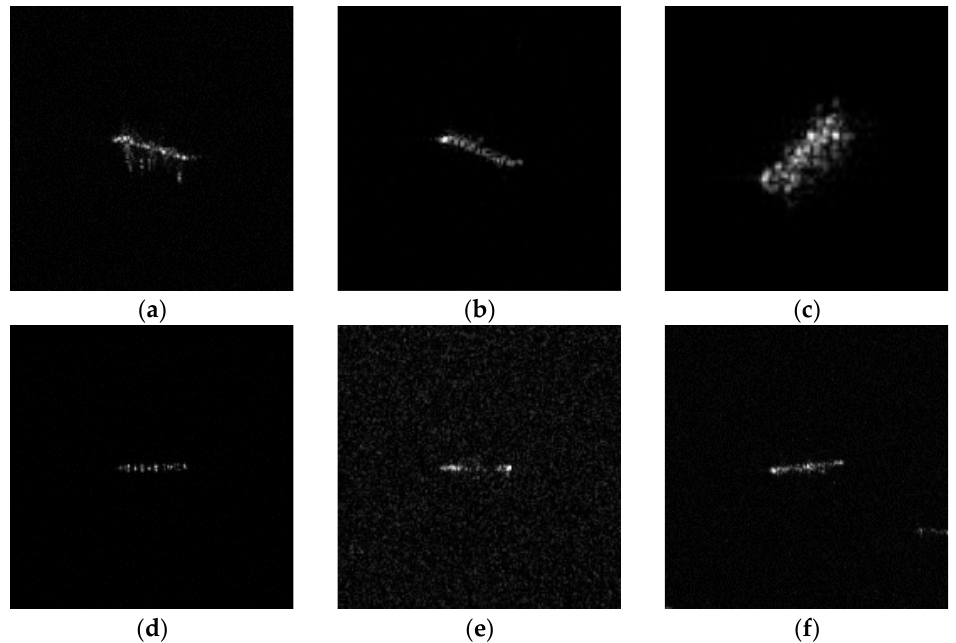
Figure 5. Six-category data. ( a ) Bulk carrier; ( b ) cargo ship; ( c ) container ship; ( d ) fishing vessel; ( e ) general cargo ship; ( f ) tanker.